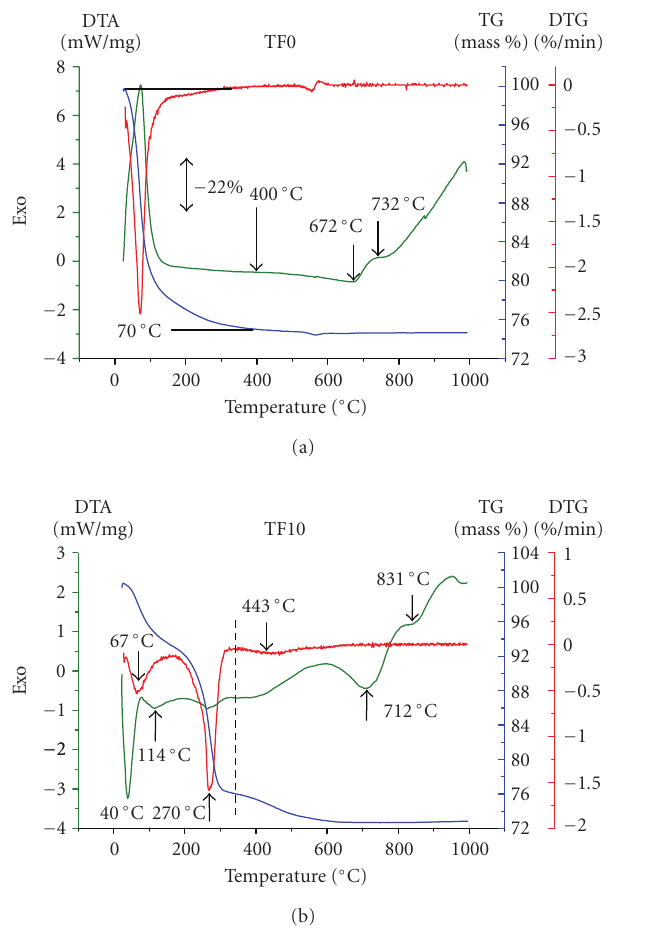
Figure 1: DTA, TG, DTG patterns of undoped (a) and fluorinated (b) titania powders.